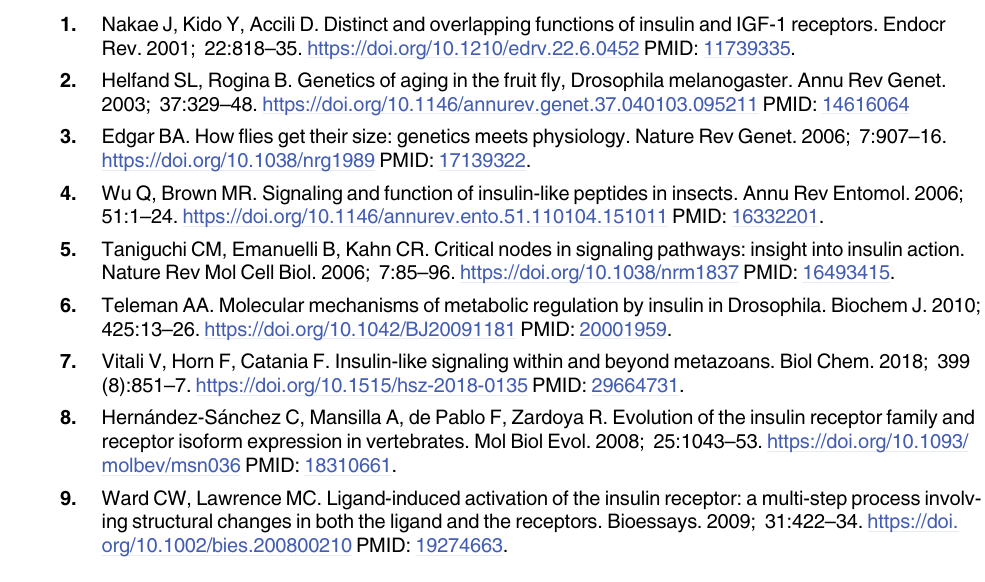
S20 Table. Primers used in this